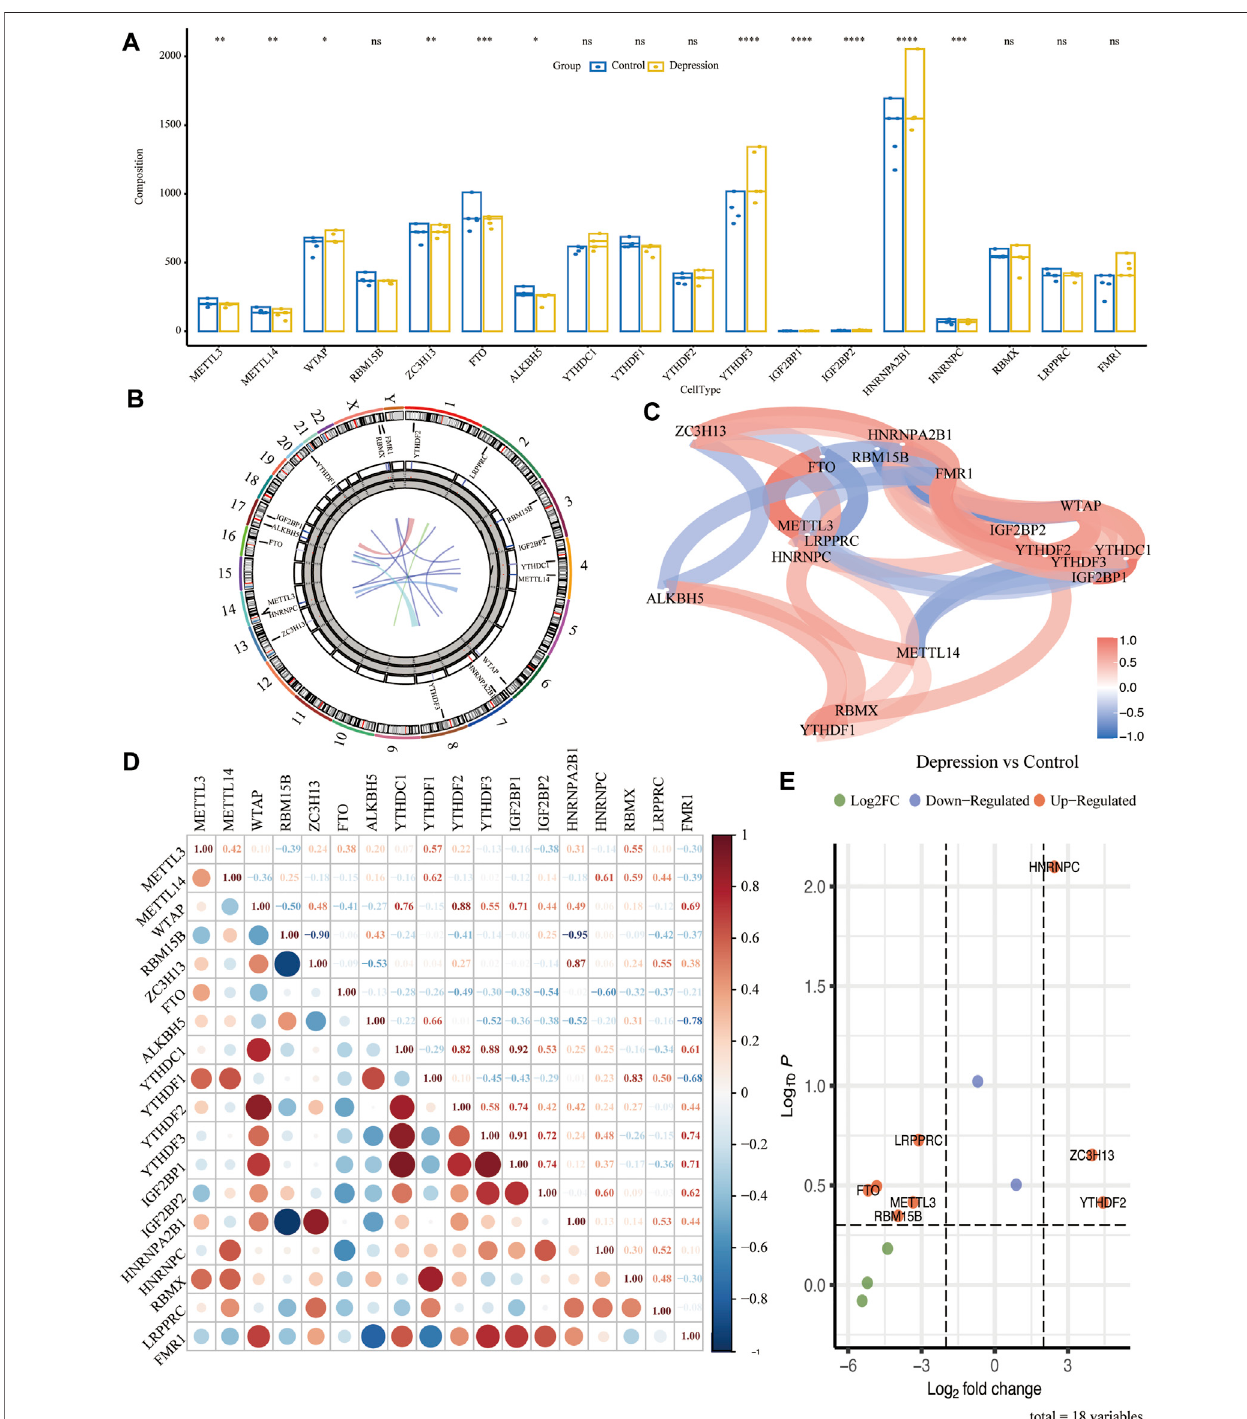
FIGURE 3 | Overall expression of m6A methylation regulators in animal models of depression. (A) Difference in expression of the m6A regulator between the experimental and control groups. (B) Chromosome localization map of m6A regulators. (C) Correlation network diagram of m6A regulators. (D) Correlation heat map of m6A regulators. (E) Volcano plot of the results of the differential genetic analysis of m6A regulators.